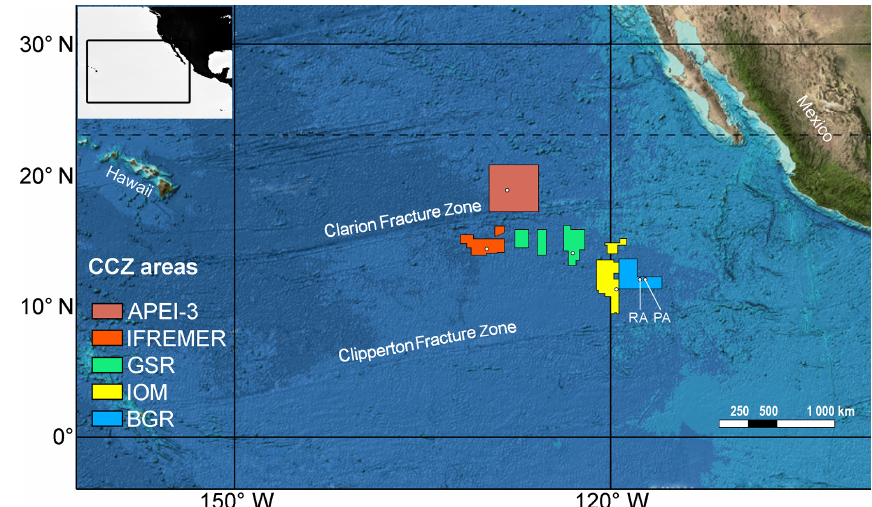
Figure 1. Overview map of geographical sampling region and different license areas studied. Exact sampling locations are indicated with white dots. Within the BGR area, two sites were sampled in close proximity, RA (reference area; left dot) and PA (prospective area; right dot). Colour code based on Vanreusel et al. (2016) and will be maintained throughout the rest of the paper. Base map modified from GEBCO (https://www.gebco.net, last access: 6 September 2019). Colour gradient from light to dark represents bathymetry. Table 1. (a) Sampling date, geographic location, depth and approximate nodule coverage (based on information in Vanreusel et al., 2016) for the different license areas and APEI-3. Note that geographic locations are an approximation, since each area encompasses a number of replicates that are located a few metres apart. (b) Average environmental parameters and standard deviation in the 0–1cm layer. CPE is chloroplastic pigment equivalent, TN is total nitrogen, TOC is total organic carbon, Clay is sediment fraction with grain size < 4µm, and Silt is sediment fraction with grain size between 4 and